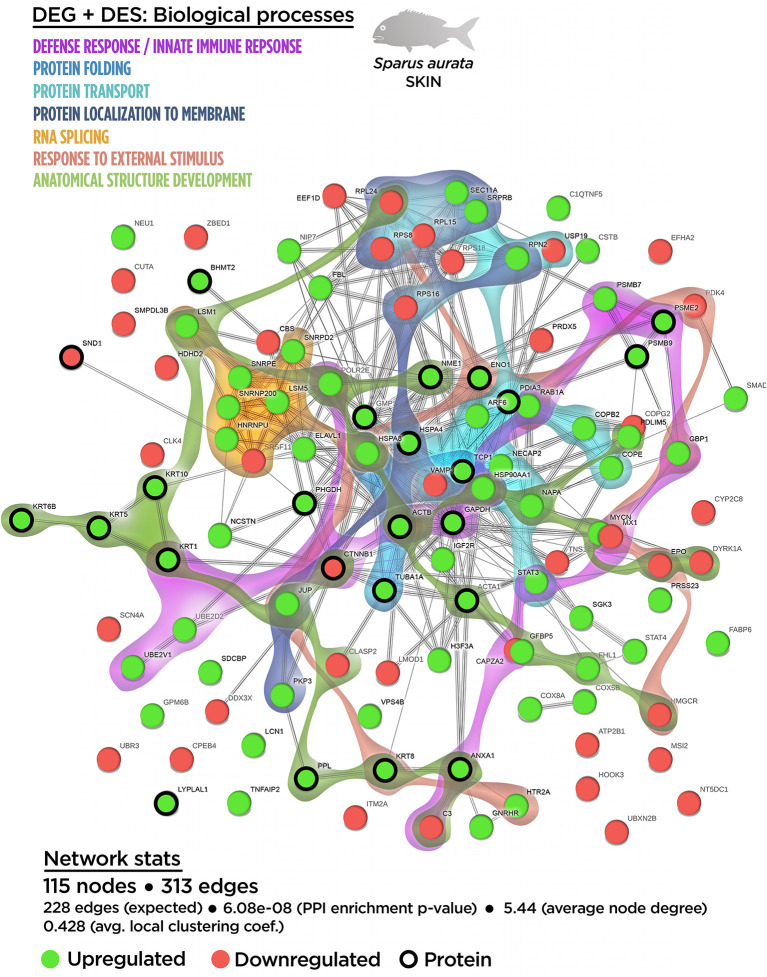
Integrative ameboid graphic for the biological processes obtained for the skin mutiomics-based interactome analysis in gilthead sea bream fed with SDPP supplemented diet. Each node represents one differential expressed gene (DEG) obtained from the skin transcriptomic analysis (circles) or one differential expressed spots (DES) obtained from the skin proteomic analysis (bold circles). The modulatory profile for DEGs or DES is represented with green (upregulated) and red (downregulated) into each node. The integrative cluster analysis groups the DEGs or DESs classified into each of the biological processes indicated in color (on top). The functional network statistics (Network stats) details is also indicated (bottom).